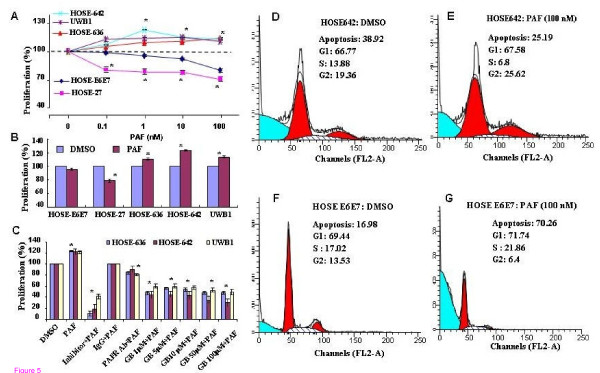
PAF induced cell proliferation and anti-apoptosis in BRCA1-mutant ovarian epithelial cells. (A) The induced cell proliferation pattern in wild type HOSE-E6E7 and HOSE-27 cells and BRCA1-mutant HOSE-642 and HOSE-636 and ovarian malignant cells (UWB1) was affected by 72 hours treatment with different concentrations of PAF. Significant increase or decrease of cell proliferation induced by PAF treatment was indicated by symbol star (* p < 0.05). (B) Differential cell proliferation pattern was affected by PAF (1 nM) treatment in wild type of HOSE-E6E7 and HOSE-27 cells and BRCA1-mutant non-malignant HOSE-642 and HOSE-636 and ovarian cancer cells (UWB1), compared to the control cells without PAF treatment (as 100%). (C) PAFR-inhibitor, specific PAFR antibody and different concentration of antagonist ginkgolide B (1, 5, 10, 50, 100 μM) significantly (p < 0.05) blocked the PAF-induced proliferation in three BRCA1-mutant ovarian epithelial cell lines, compared to the control cells treated either with equal volume of DMSO or with IgG (as 100%). (D, E) Anti-apoptotic activity was significantly (p < 0.05) induced by PAF treatment in BRCA1-mutant at-risk HOSE-642 cells. (F, G) Apoptosis was significantly induced by PAF (100 nM) in wild-type HOSE-E6E7 cells, compared to the controls with 72 h treatment of equal volume DMSO. Experiments were performed at least three times (p < 0.05).